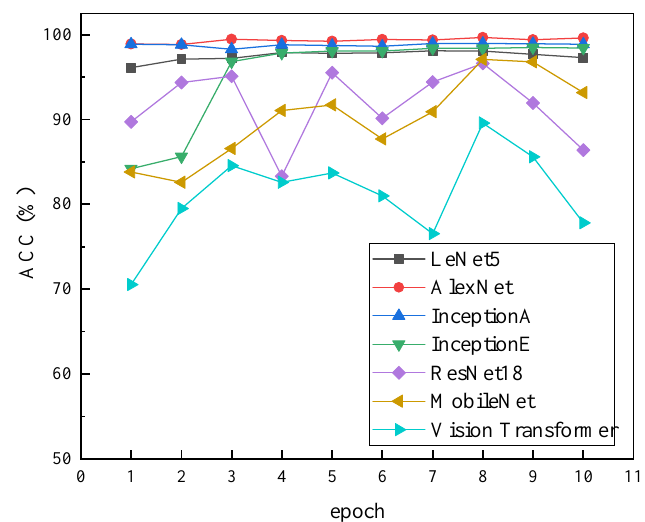
Figure 15. Comparison of the accuracy rate of identifying the surface cracks of soil and rock masses of each